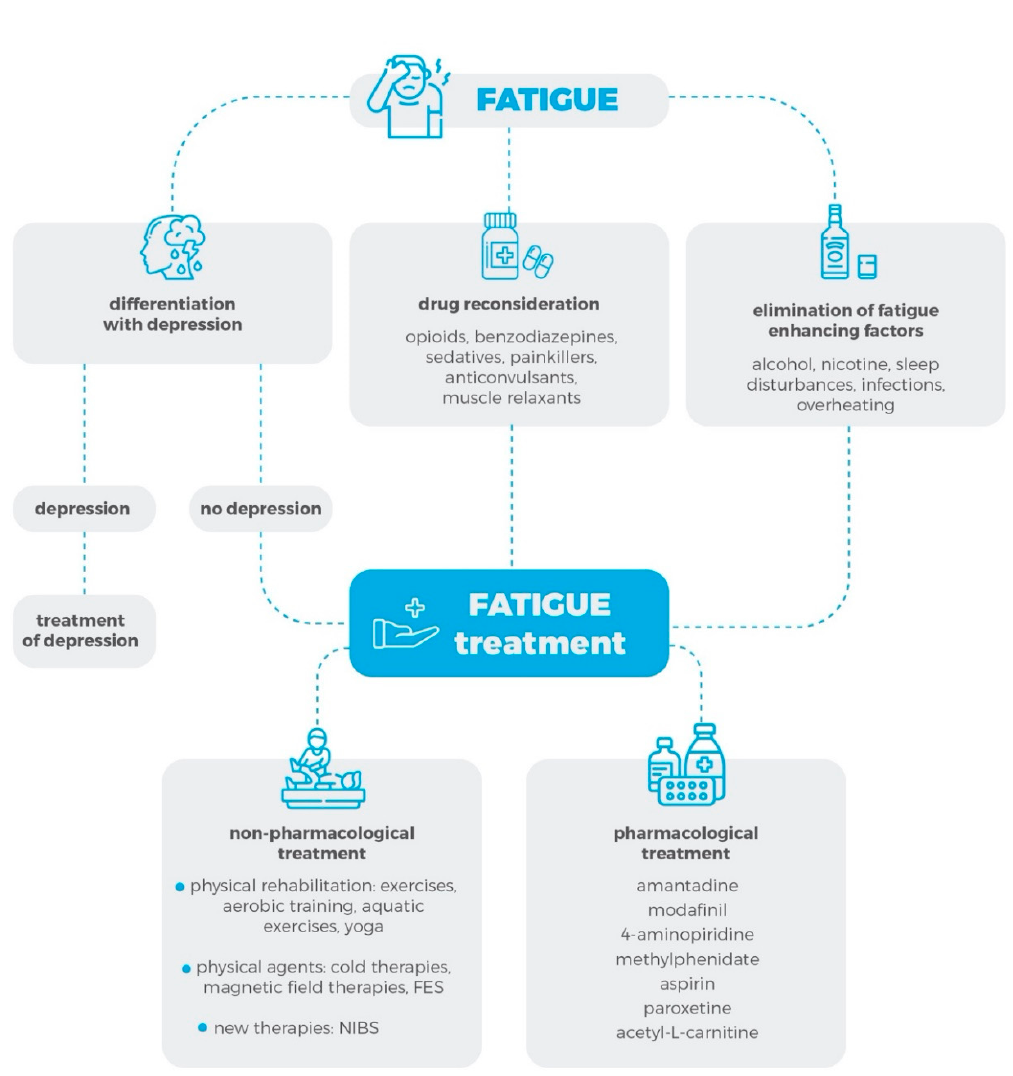
Figure 1. A protocol for the management of fatigue in MS patients, as presented in this